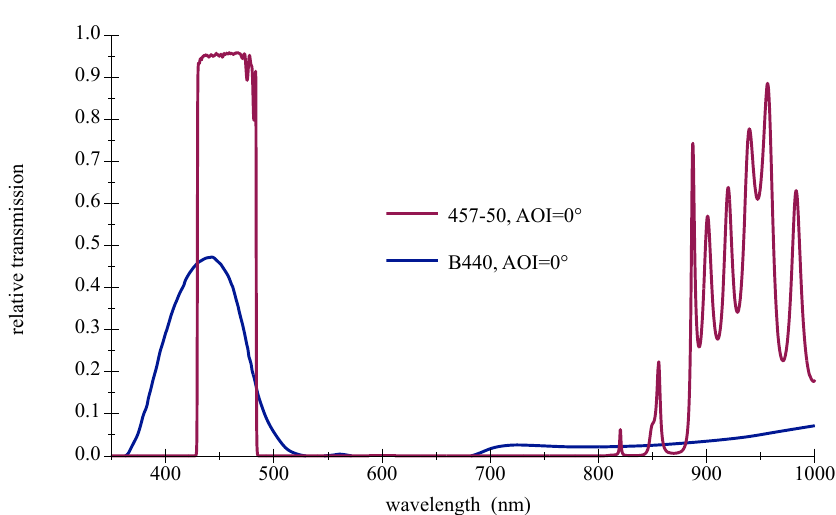
Figure 15. Transmission curves of a colored glass bandpass filter Hoya B440 and a thin film bandpass filter Semrock 457-50. Plot based on manufacturers data [41,45].